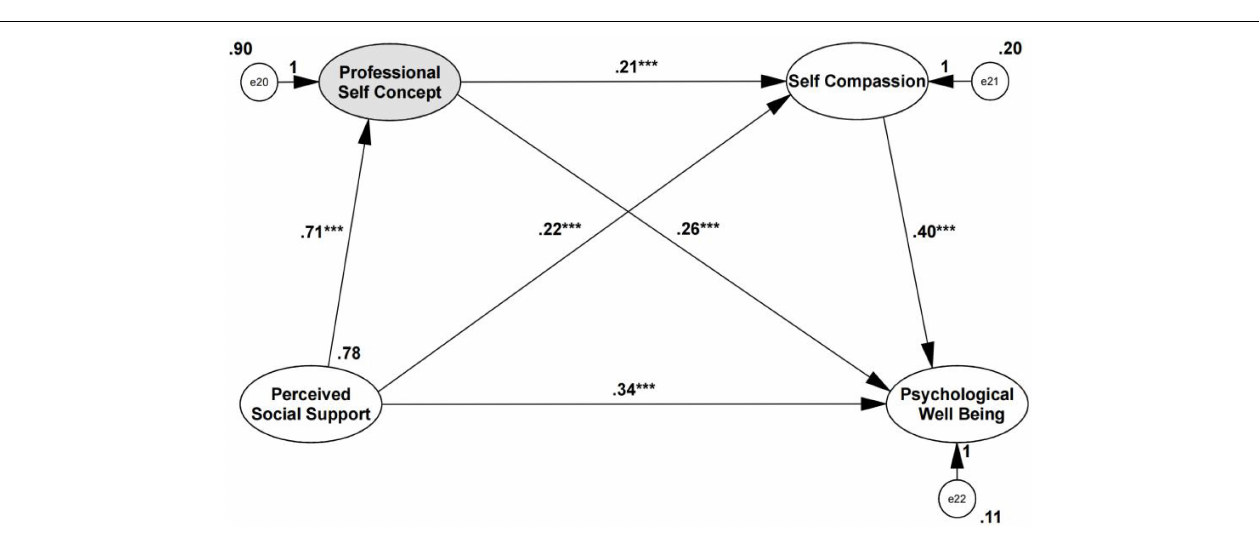
FIGURE 3 | Model of Directionality 2: professional self-concept to self-compassion. After adding the mediators, there is a significant indirect effect of perceived social support on PWB. The coefficients shown above are unstandardized. *Significant at the 0.05 level (two-tailed). **Significant at the 0.01 level (two-tailed). ***Significant at the 0.001 level (two-tailed). The total effects (Ind1 + Ind2 + Ind3 + direct effect) = 0.635. The total indirect effects (Ind1 + Ind2 + Ind3) =